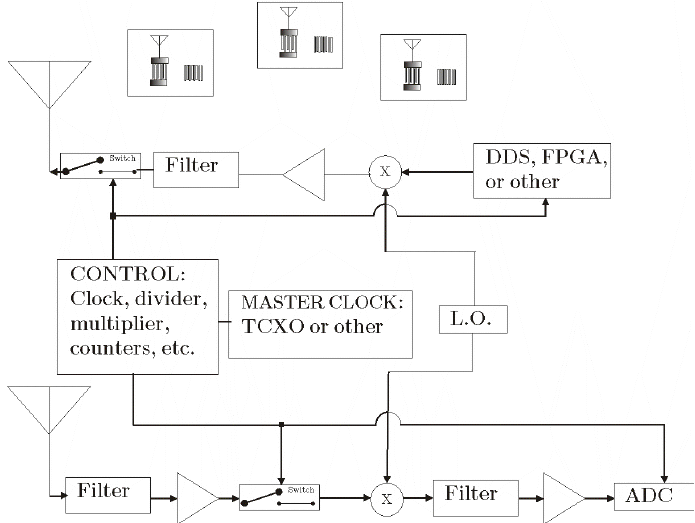
Figure 13. A heterodyne coherent correlator transceiver block diagram for use in a multi-sensor SAW system with 3 SAW sensors within the antenna range. The system assumes a wide-band pulsed transmit signal, and time duplexed between transmit and receive cycles. The output from the ADC is input to a post processor that is typically a software based